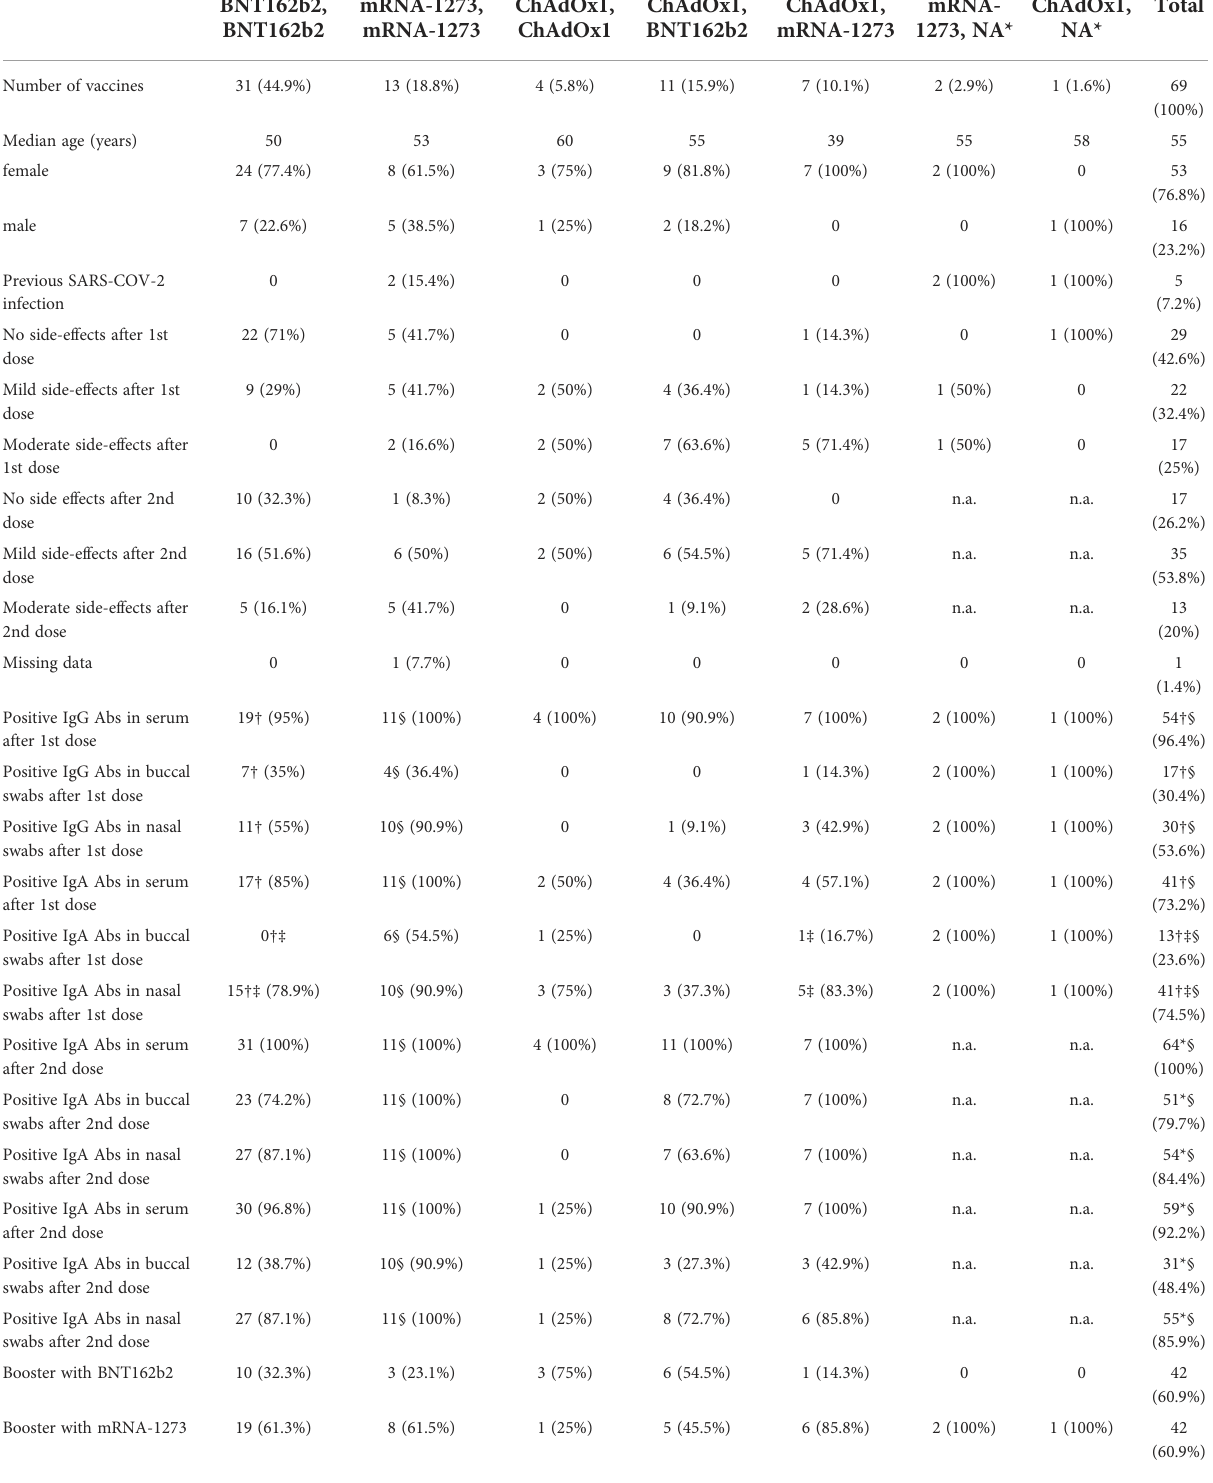
TABLE 1 Cohort characteristics according to vaccination